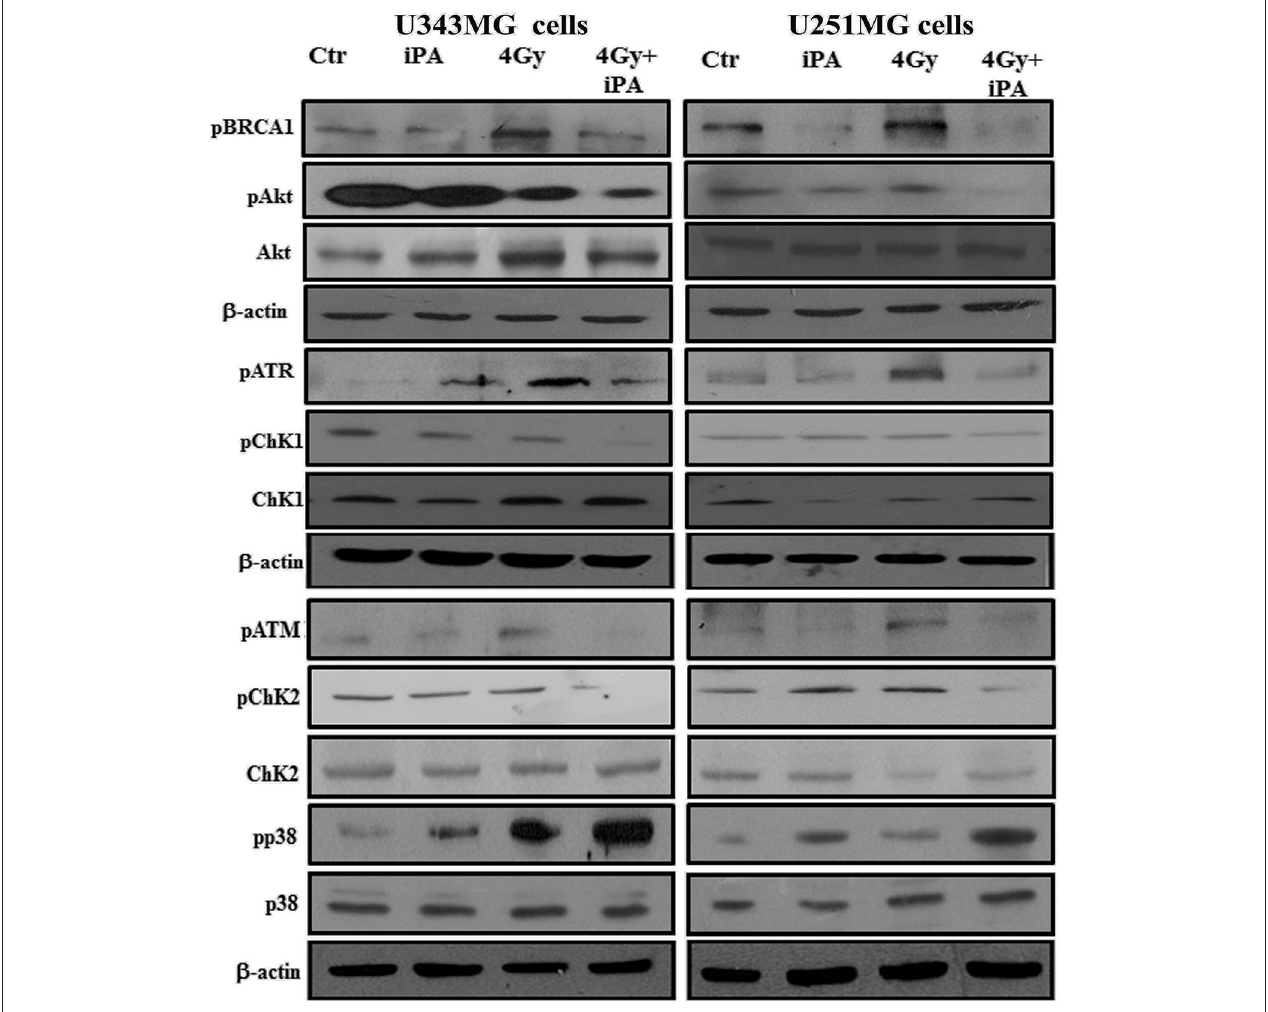
FIGURE 3 | iPA inhibited DNA repair pathway. U343MG cells and U251MG cells were treated with iPA alone for 48h, or combined with 4Gy IR. Cell lysates were analyzed by Western blot analysis for DNA repair pathway proteins including pAkt (S473), pCHk1 (S345), pCHK2 (Thr-68), pBRCA1 (Ser-1524), pATM (Ser-1981), and pATR